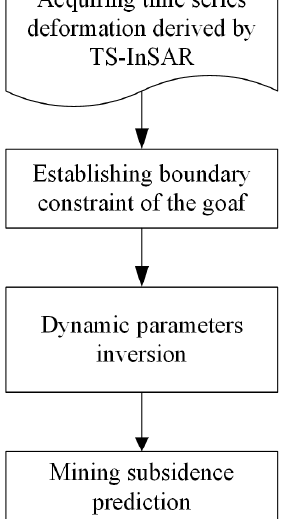
Fig1 Figure 1. Flow chart of the proposed